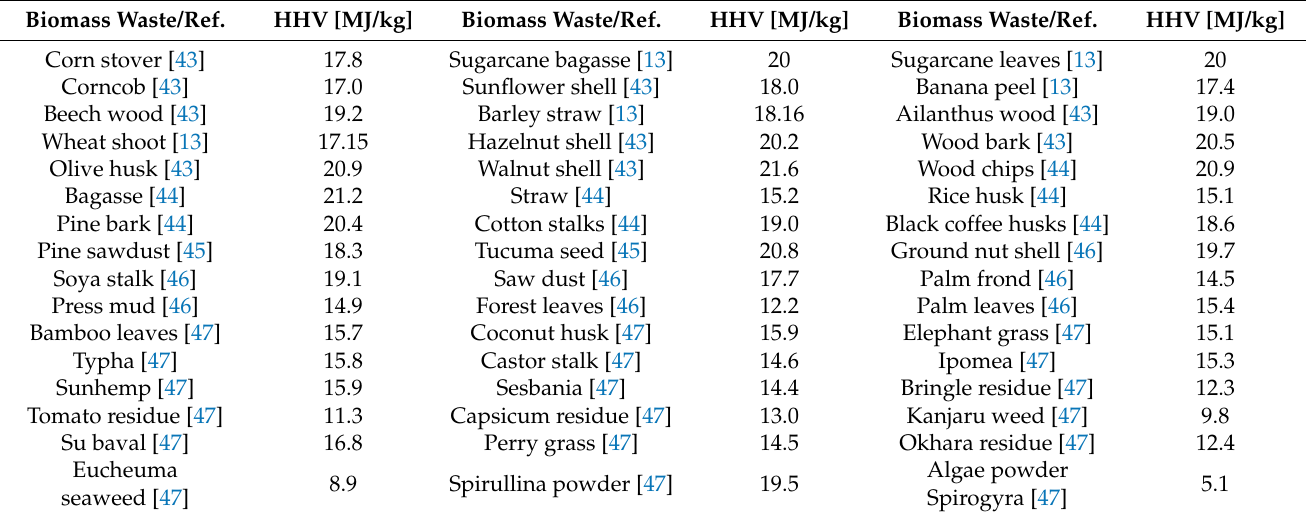
Table 3. Higher heating values (HHV) of biomass waste